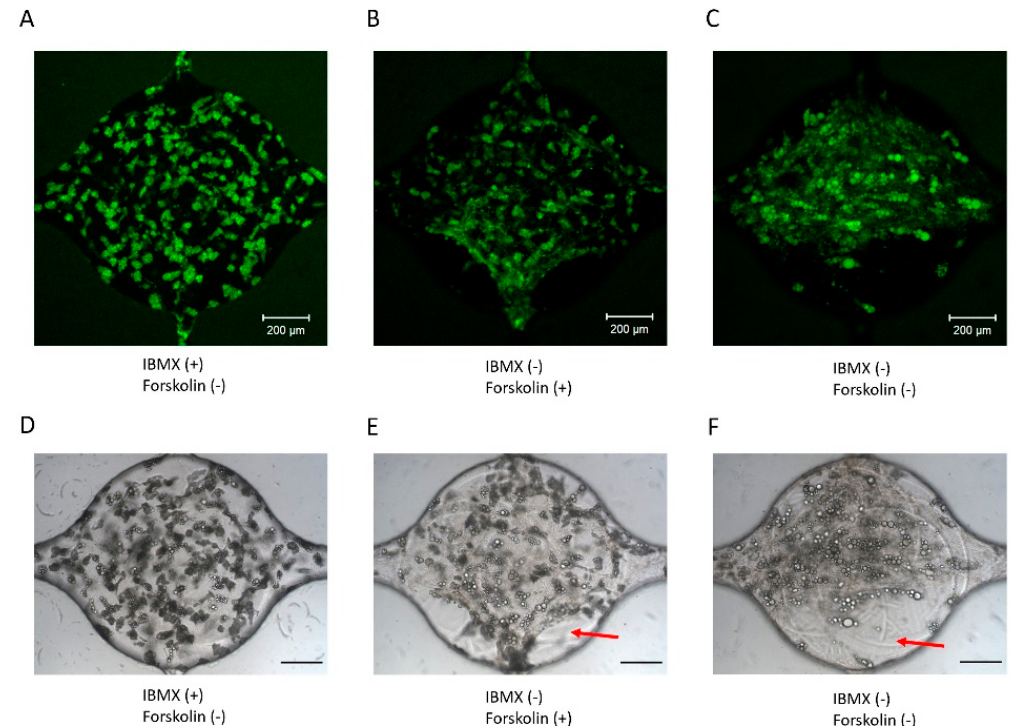
Figure 6. Adipogenic differentiation of ADSC within microfluidic devices. ( A ) BODIPY staining of ADSC differentiated with IBMX or ( B ) forskolin and ( C ) without IBMX or forskolin. ( D ) Brightfield image of ADSC differentiated with IBMX or ( E ) forskolin and ( F ) without IBMX or forskolin.